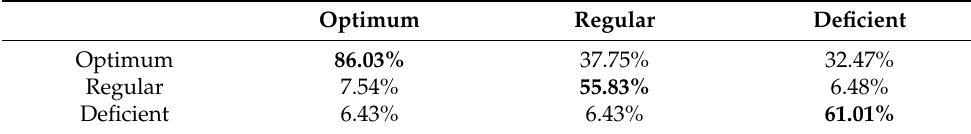
Table 2. Global confusion